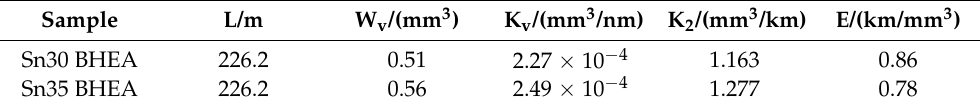
Table 3. Wear properties of Sn30 BHEA and Sn35 BHEA at room temperature.